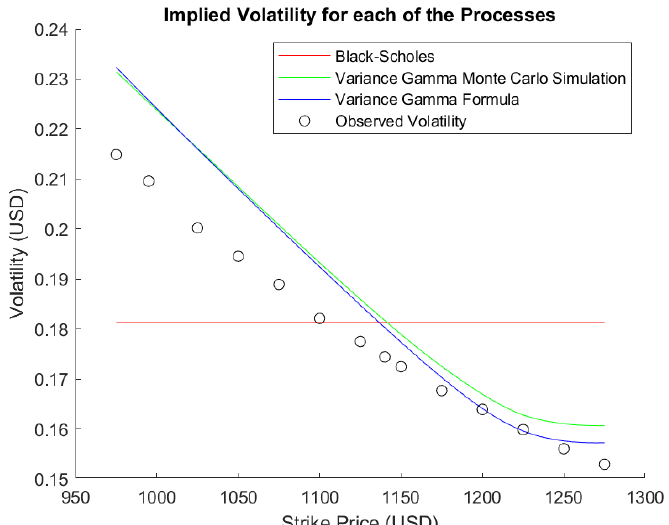
Figure 2. Implied Volatility for the empirical data and Black–Scholes and Variance Gamma models, where S 0 = 1124.47, K = 1100, and τ = 35 ×